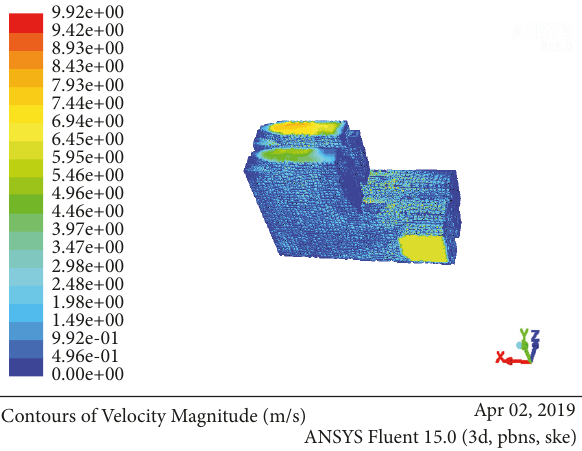
Figure 10: The temperature distribution of support bottom in Test